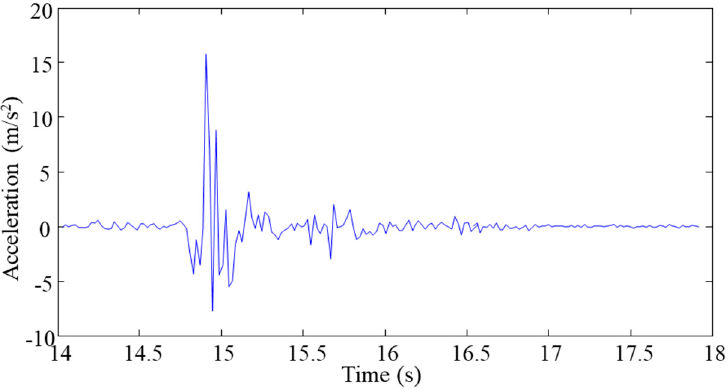
( d ) Figure 14. MR damper hysteretic curve. ( a ) El Centro earthquake—0.36 g; ( b ) El Centro earthquake— 0.72 g; ( c ) Taft earthquake—0.36 g; ( d ) Taft earthquake—0.72 g. As can be seen in the figures above, the damper hysteresis curve is plump. As a result, a large amount of seismic energy is dissipated by the MR damper which eventually caused the energy